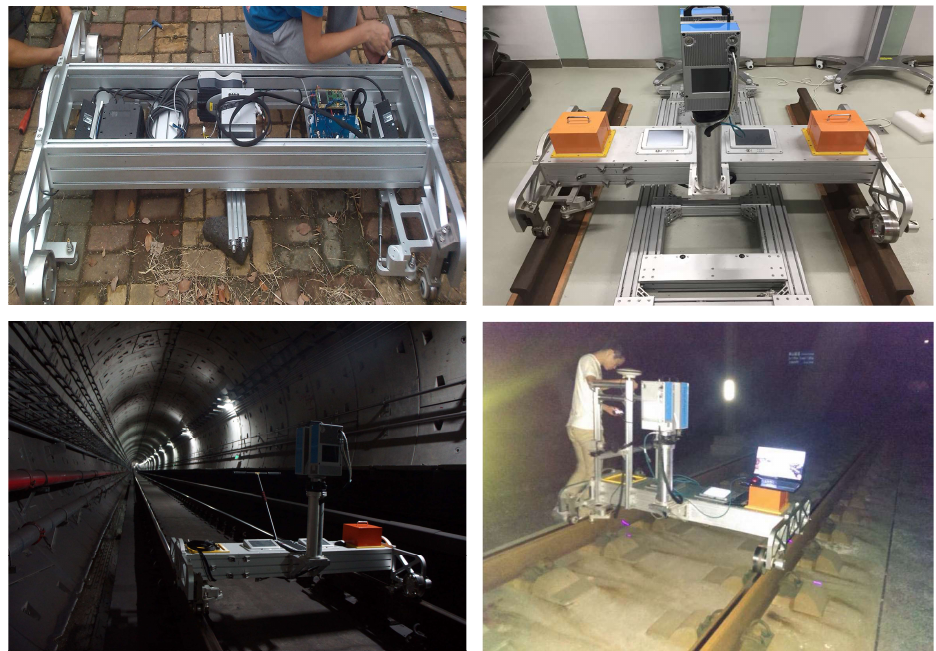
Figure 8. Experiment